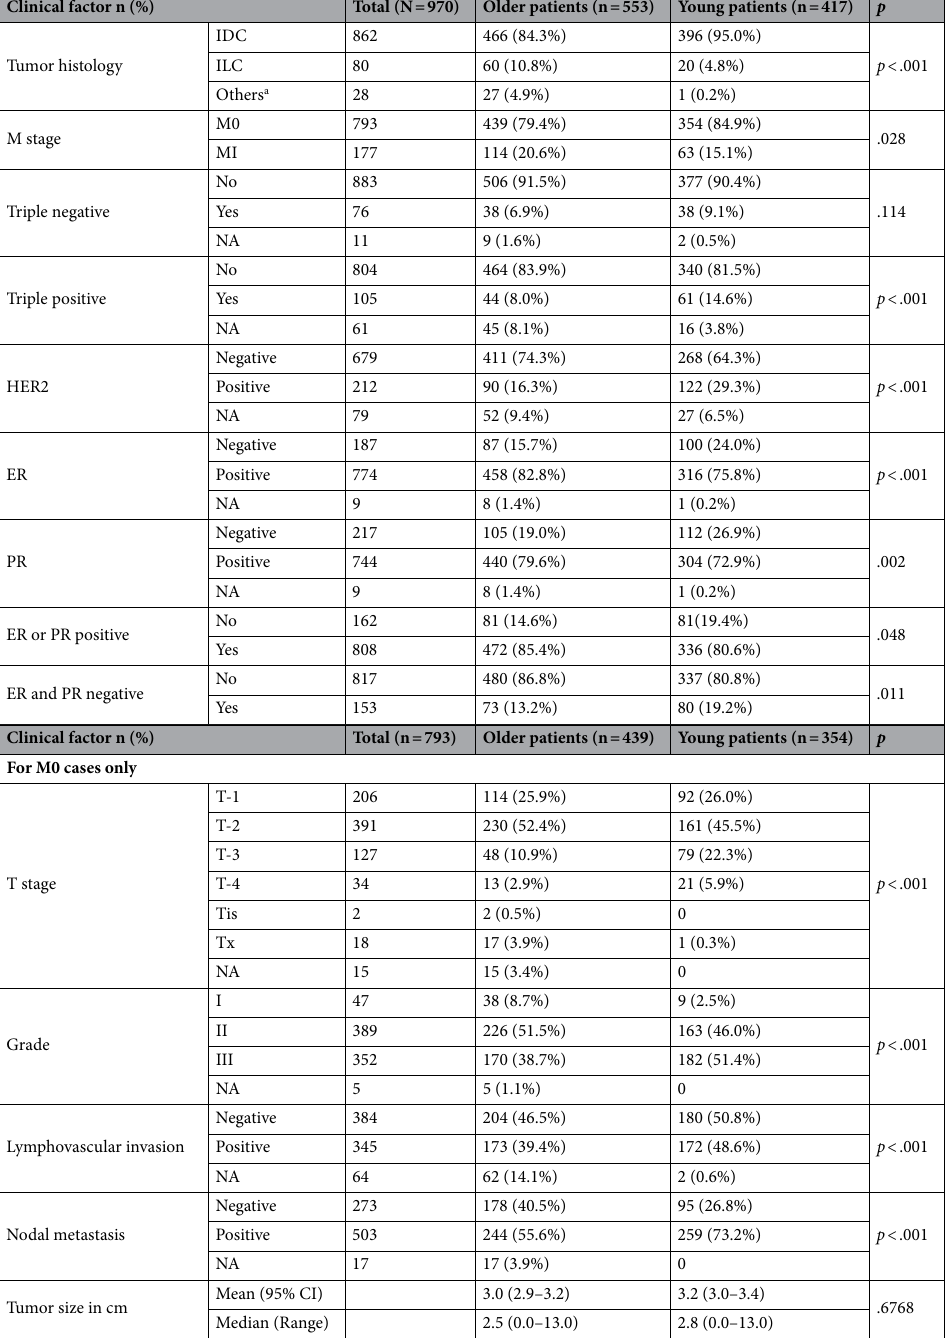
Table 1. Patients’ characteristics. IDC = invasive ductal carcinoma; ILC = invasive lobular carcinoma; NA = not available; M = Metastasis; ER = Estrogen receptors; PR = Progesterone receptors; HER2 = Human epidermal growth factor receptor 2; T = Tumor size, ER = Estrogen receptors; PR = Progesterone receptors. a ‘Others’ refers to instances when patient tumor histology was recorded as neuroendocrine carcinoma or inflammatory mammary